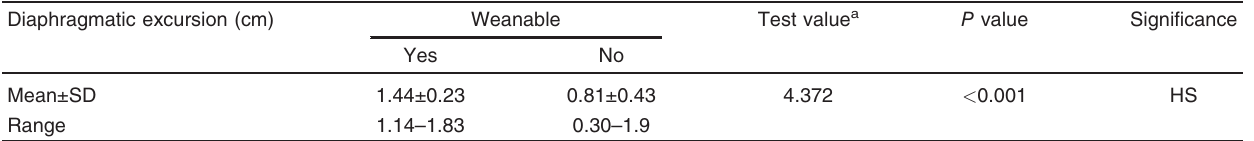
Table 6 Comparison between diaphragmatic excursion among different weaning states Diaphragmatic excursion (cm) Weanable Test value a P value